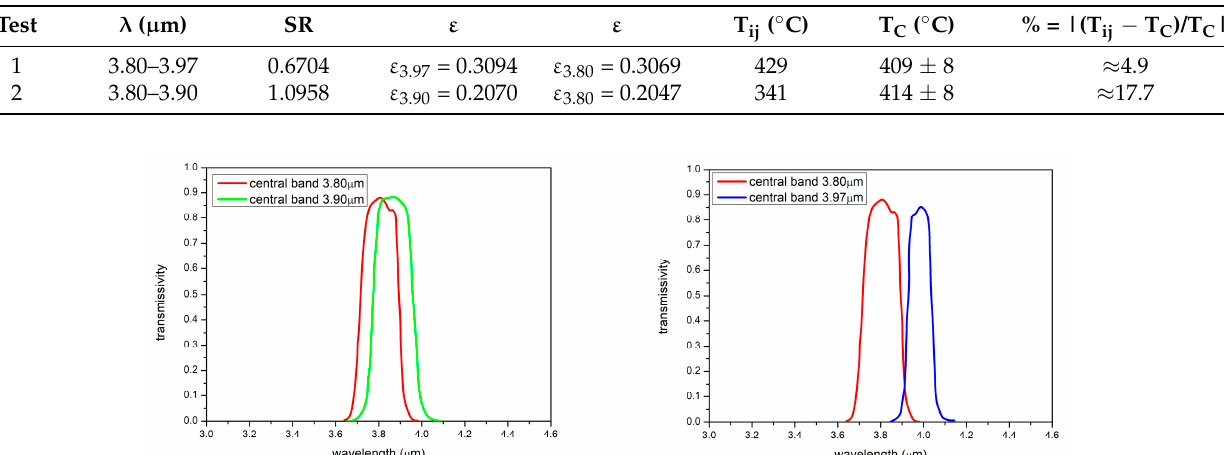
Table 1. Experimental test results column is referred, respectively, to the test number, central wavelengths of the filter couples, signal ratio values, emissivity for different filters, dual-color measurements (Tij), thermocouple measurements, and relative temperature accuracy of dual-color (Tc) with respect to the thermocouple measurements [5,6]. Test